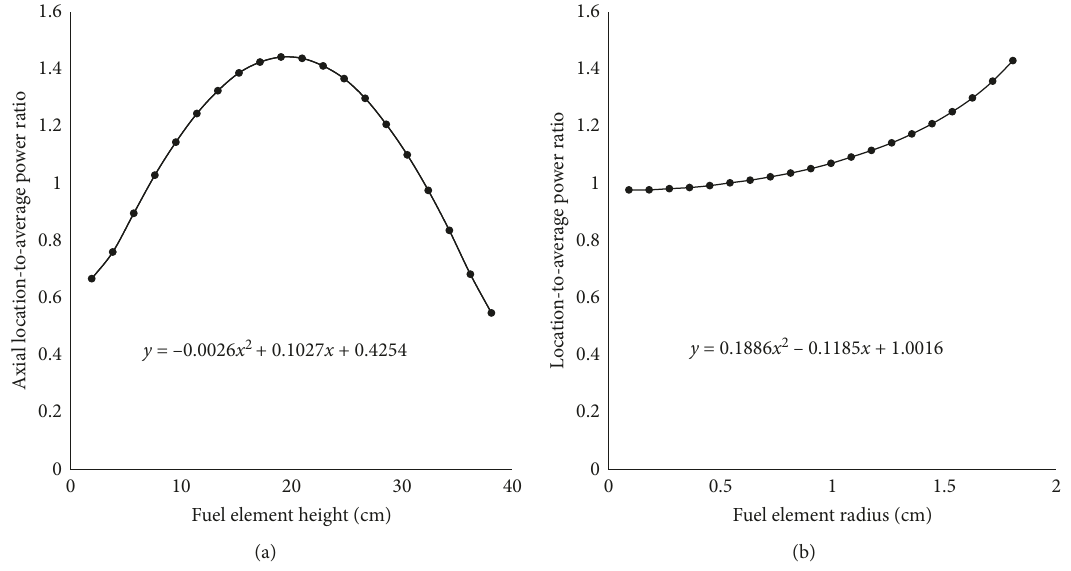
Figure 4: (a) Axial and (b) radial power profiles of GSTR fuel